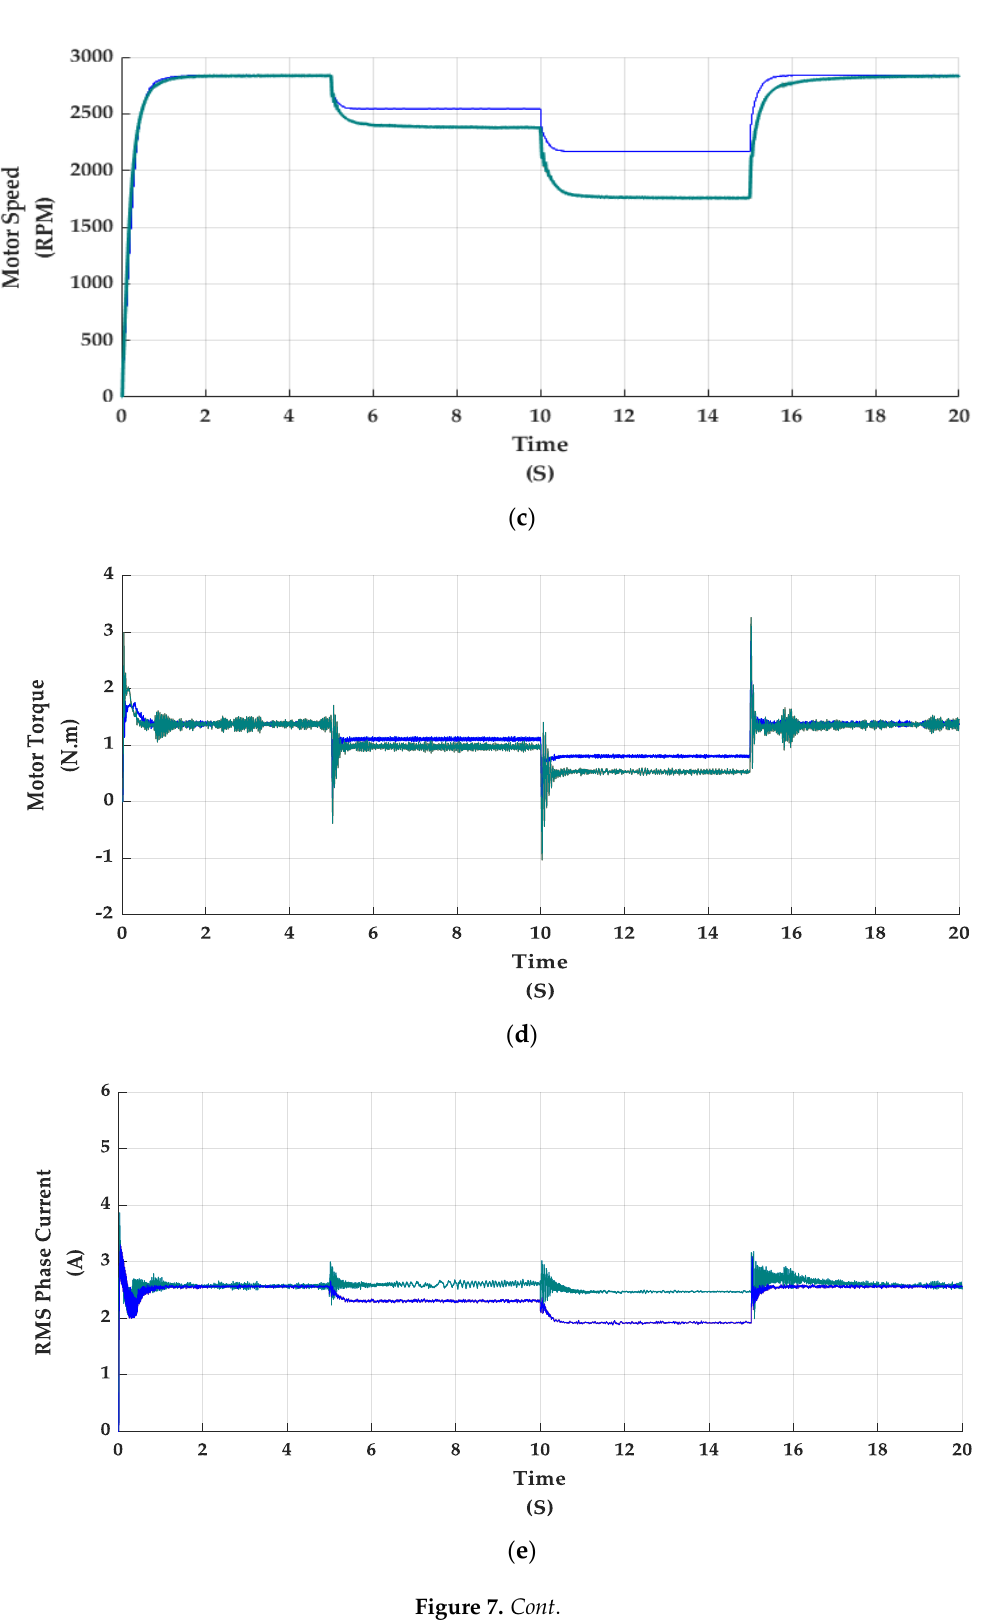
Figure 7. Simulation results of the proposed Q V/f compared to the conventional L V/f: ( a ) Inductor current; ( b ) DC link Figure 7. Cont voltage; ( c ) Motor speed; ( d ) Motor torque; ( e ) RMS phase current.